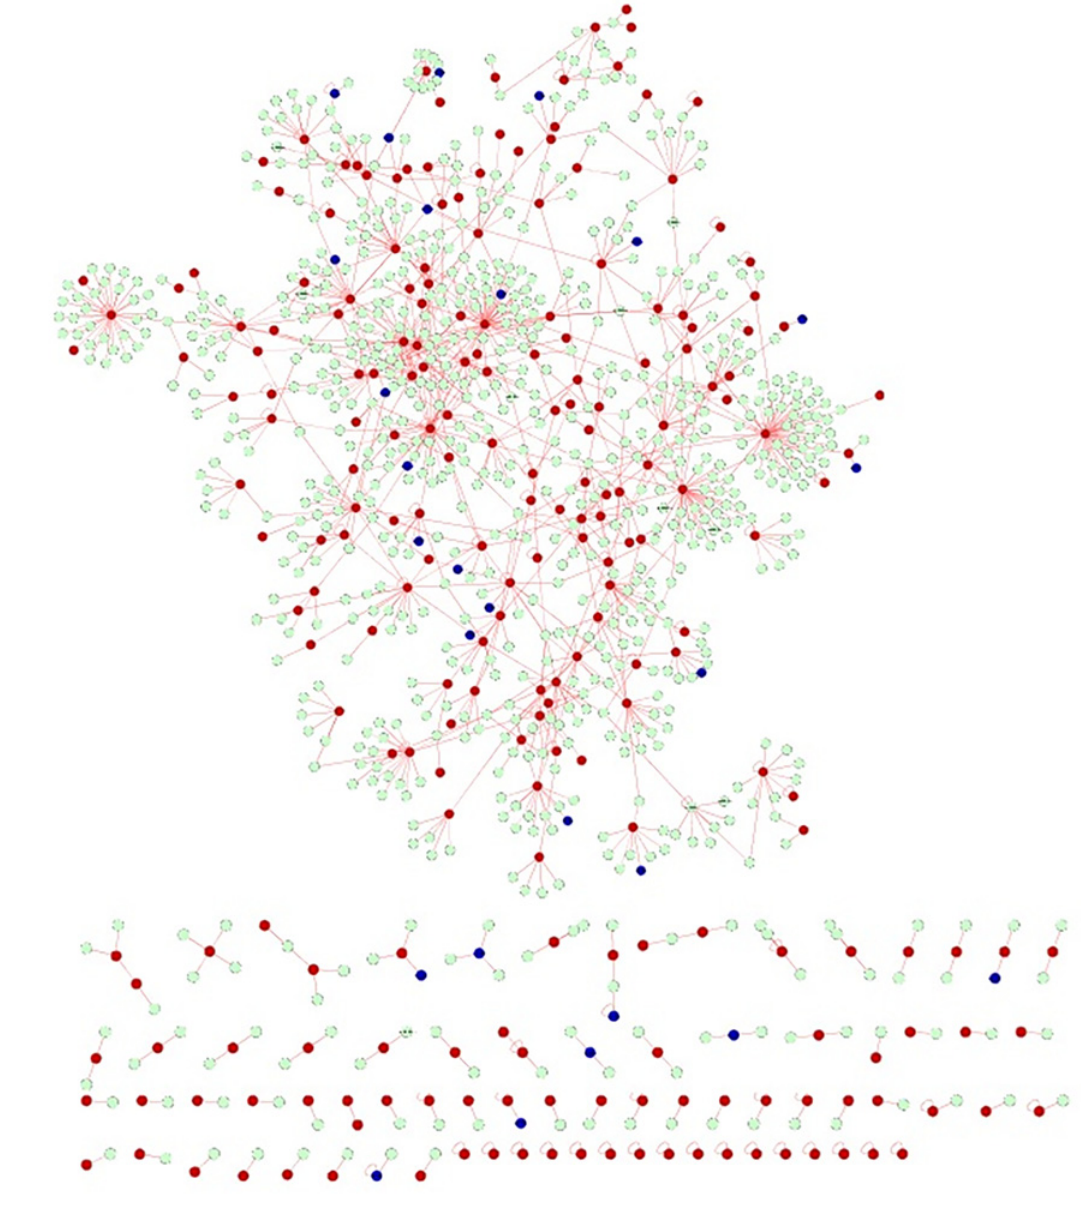
Fig 4. Psoriasis diseaseome highlighting the proteins involved in T2DM. Green nodes — proteins involvement in psoriasis, red nodes — common proteins shared by T2DM and psoriasis and blue nodes — indirect